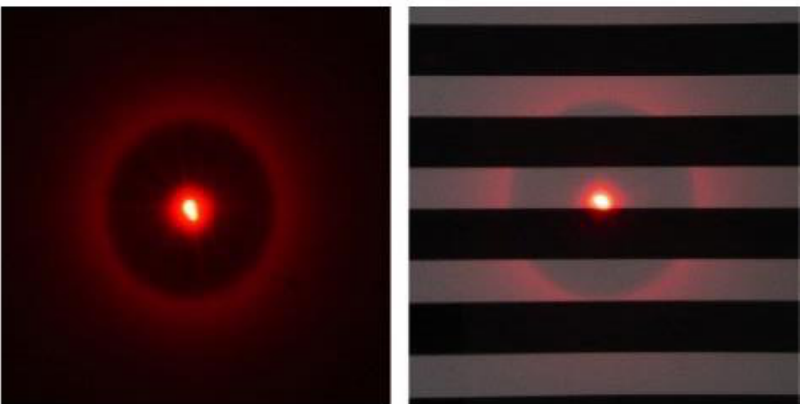
Figure 2. Pictures of the point-spread function of a uniform substrate (image on the left ) and a substrate with line-halftone black and white pattern (image on the right ) both coated with a clear layer, as displayed when illuminated with a red laser beam.